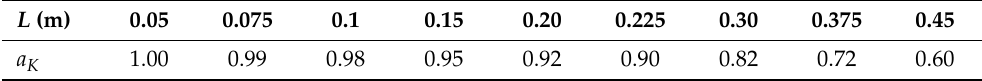
Table 2. Contact correction factor a k as a function of pipe spacing L for type B systems [25–29]. L (m)